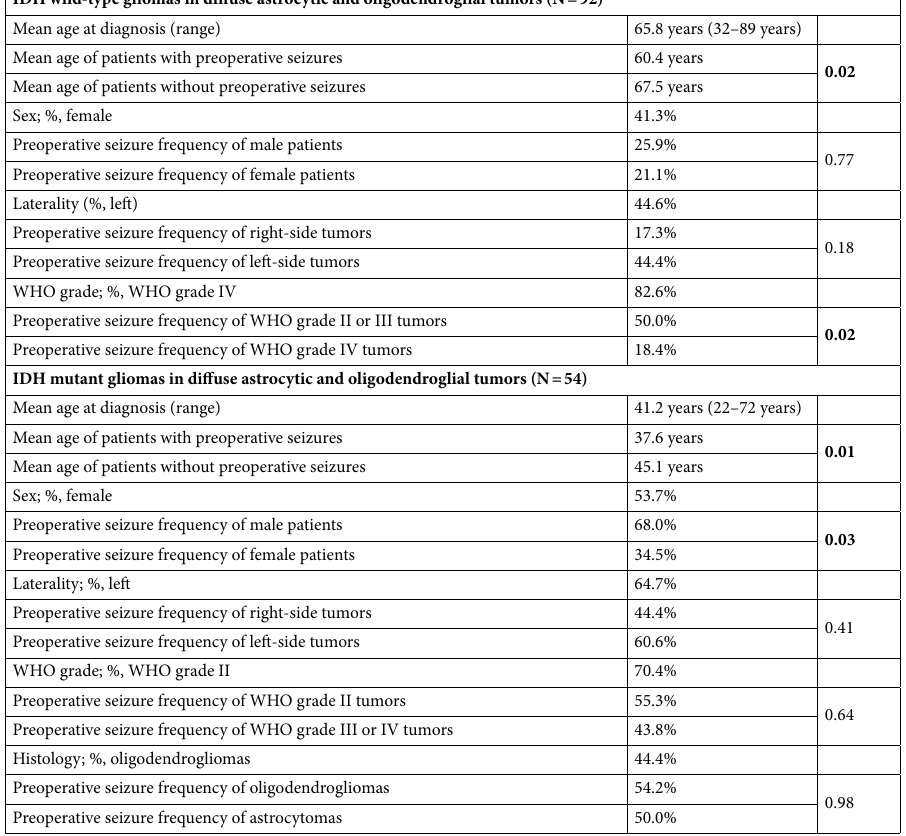
Table 2. Characteristics of patients with gliomas and incidence of preoperative seizure in each genetic subtype. bold values indicate in p < 0.05 and consequently two analyzed categories were considered to be significantly different. IDH, isocitrate dehydrogenase ; WHO World Health Organization.